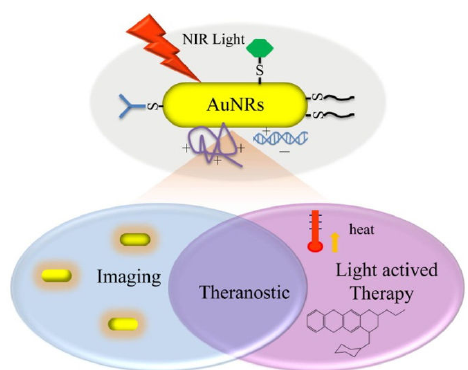
Figure 1. Illustration of different beneficial uses of GNR with light mediation [6]. Reprinted with permission from ref. [6]. Copyright 2013